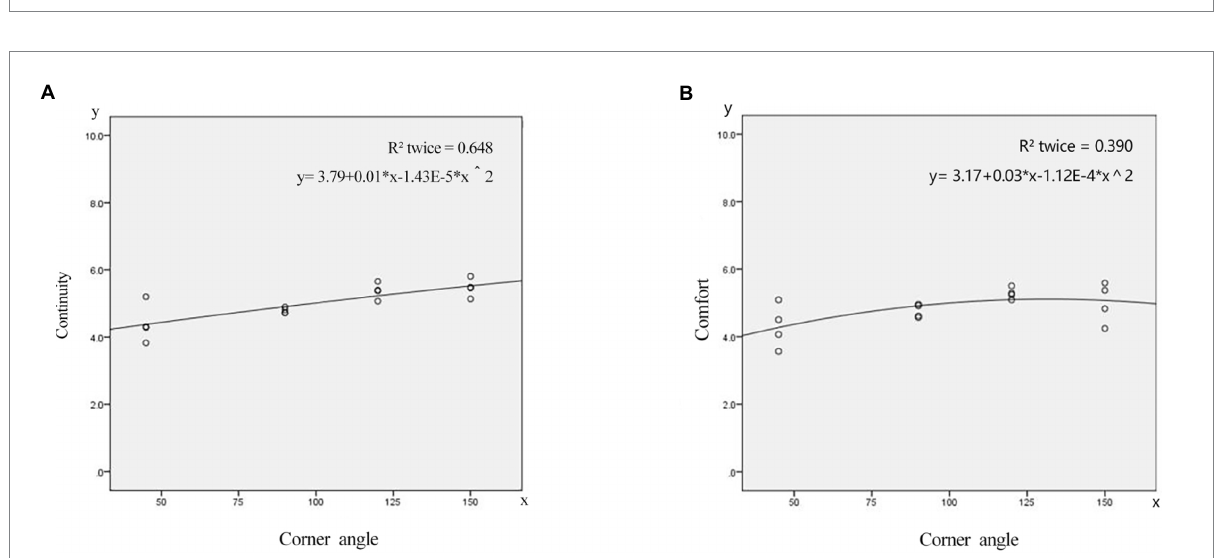
Scatter plot of comfort against corner angleScatter plot of continuity against corner angle